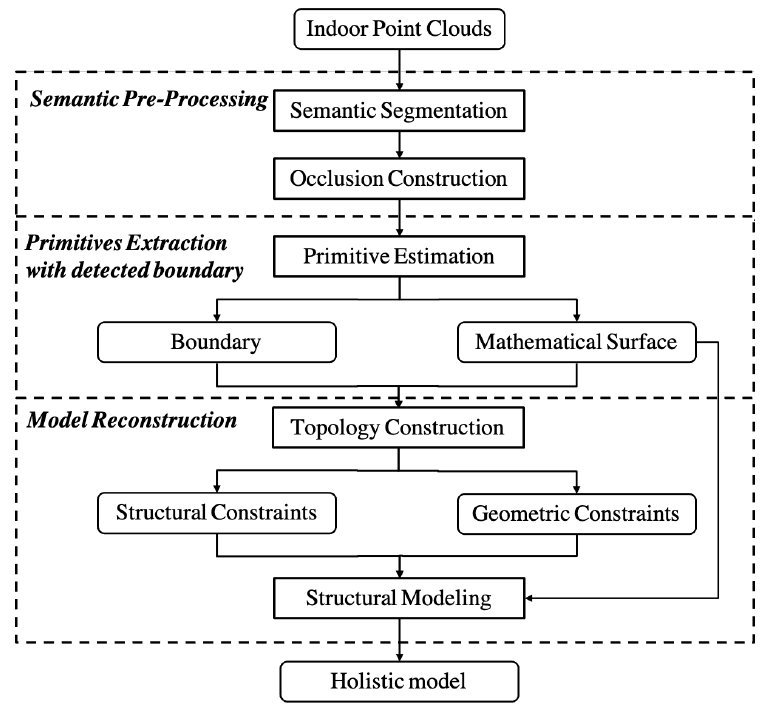
Figure 1. Flowchart of the TC-SM